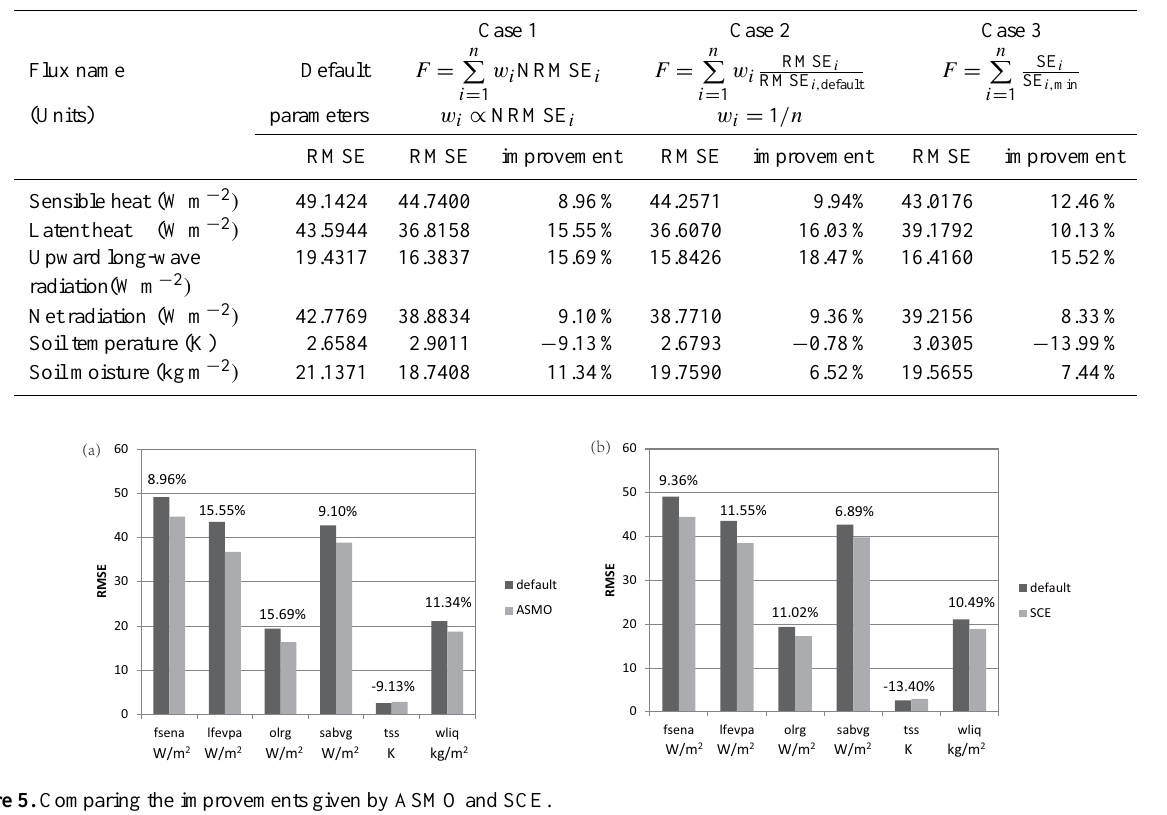
Table 5. Inter-comparison of different weighting systems.